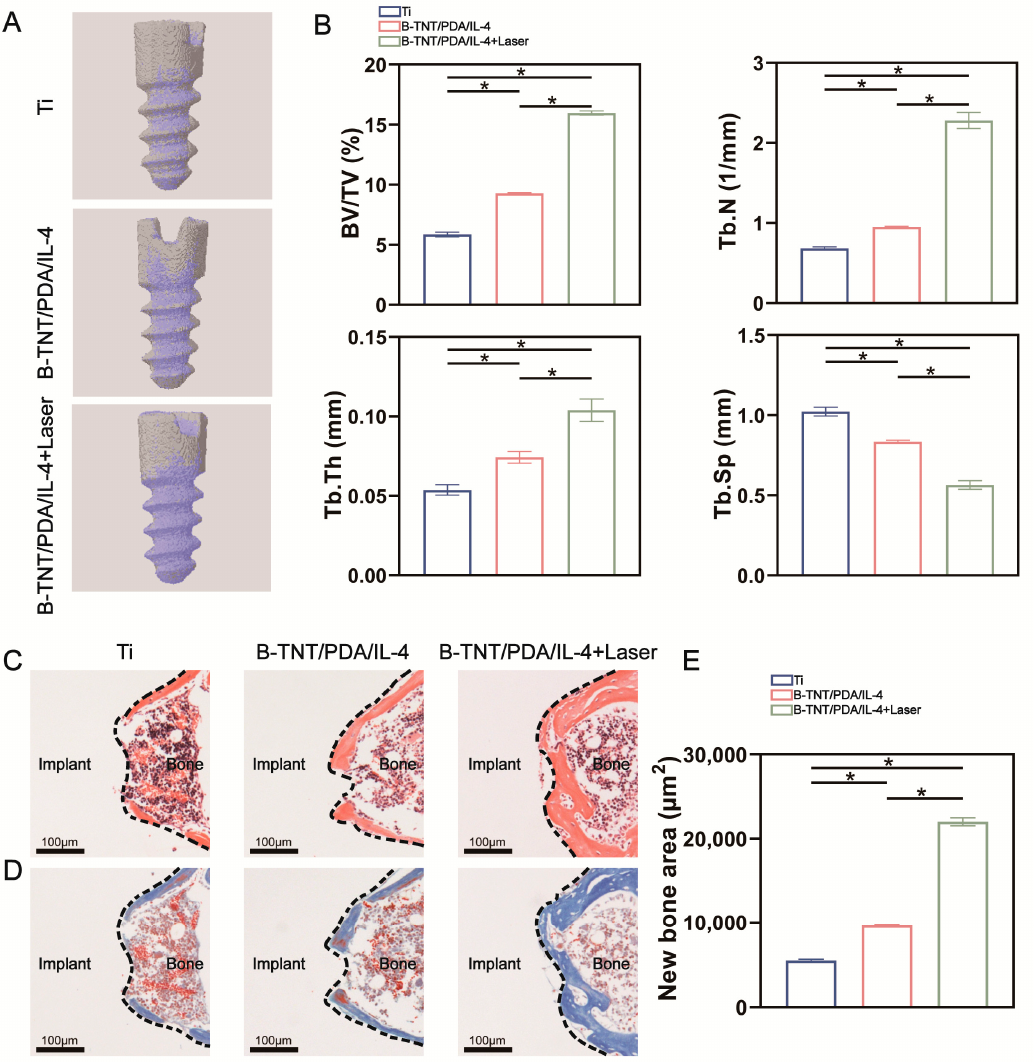
Figure 9. ( A ) Micro-CT 3D reconstruction images of different samples, with gray color representing implants, while purple color representing new bone formation. ( B ) Quantitative analysis of bone volume/total volume (BV/TV), trabecular number (Tb.N), trabecular thickness (Tb.Th) and trabecular separation (Tb.Sp) values. ( C ) H&E and ( D ) Masson staining images of different samples 28 days after implantation. ( E ) Quantitative analysis of new bone formation area. * indicates statistical difference between groups ( p < 0.05).